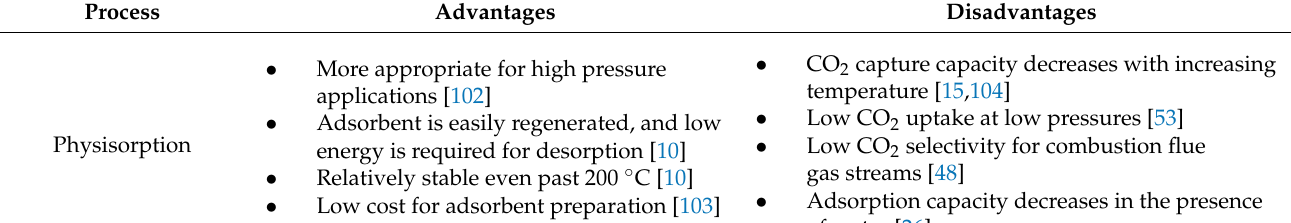
Table 4. Comparison of the CO 2 physisorption and chemisorption